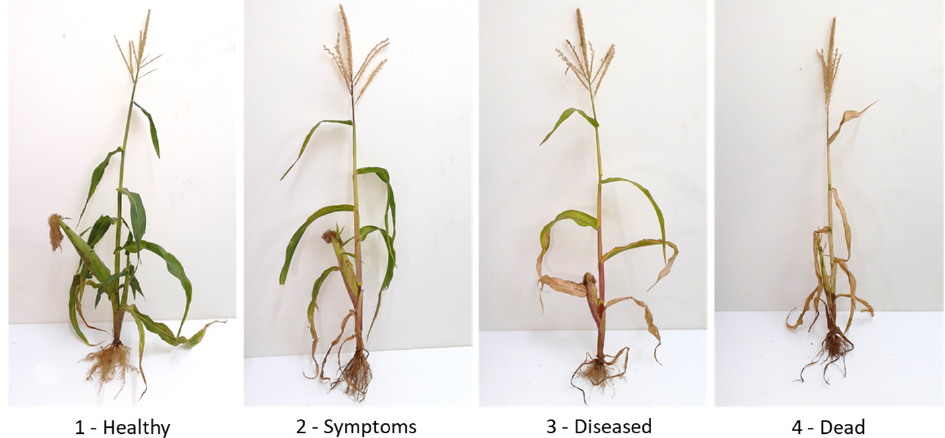
Figure 10. Wilting estimation scale. This scale was used to calculate the dehydration percentages at the different treatments at the end of season in the open-enclosure trial (day 78, Figure 9C). The plants’ total health status was evaluated based on four categories: 1—healthy, 2—symptoms, 3—diseased and